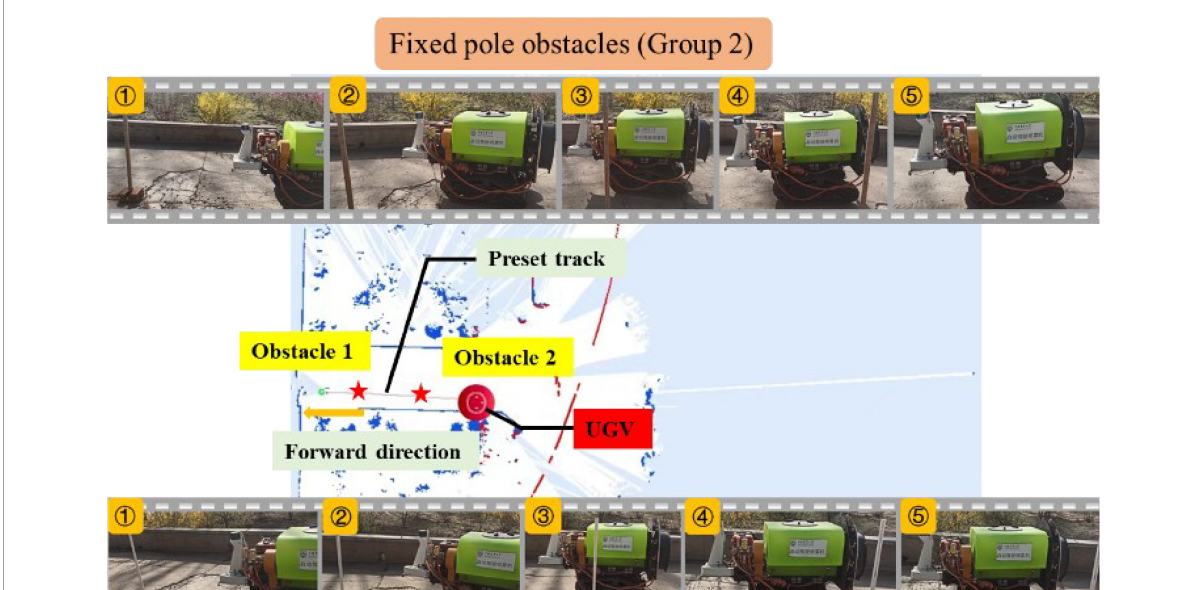
in Figure 16 , the travel track of the UGV, and two groups of moving person obstacles were all set in advance during the travel process. The UGV followed the red arrow to travel to the other